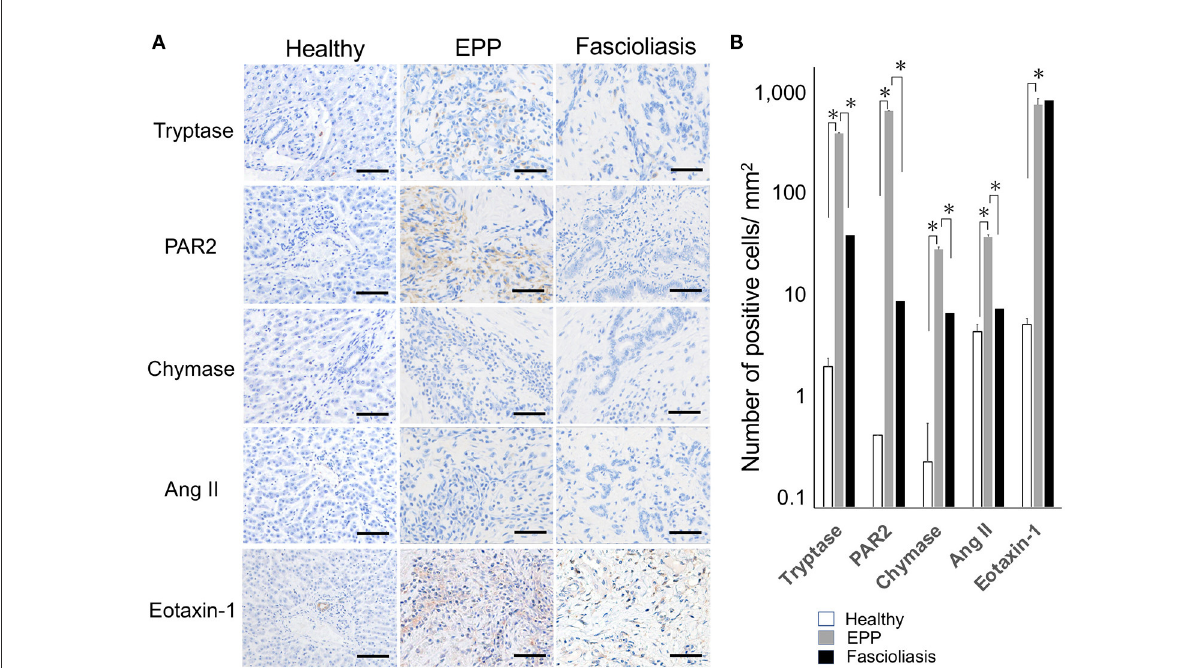
FIGURE3 Type of mast cells containing cytoplasmic granules (tryptase and chymase) and the expression response of related molecules (PAR-2, Ang II, and eotaxine-1) in surrounding cells. (A) Hepatic interlobular triad region of a healthy case (Healthy), an eosinophilic proliferative phlebitis (EPP) case, and a chronic fascioliasis case (Fascioliasis) were indicated by immunostaining against tryptase, PAR-2, chymase, Ang II, and eotaxine-1. Each scale bar indicates 50 µ m. (B) Average numbers of cytoplasmic granules (tryptase and chymase) per 1 mm 2 and related molecules (PAR-2, Ang II, and eotaxine-1) in surrounding cells per 1 mm 2 were indicated in healthy cattle ( n = 5), EPP cattle ( n = 10) and fascioliasis cattle ( n = 6). * P < 0.05, analysis of variance. PAR-2, protease activated receptor-2; Ang II, angiotensin II.